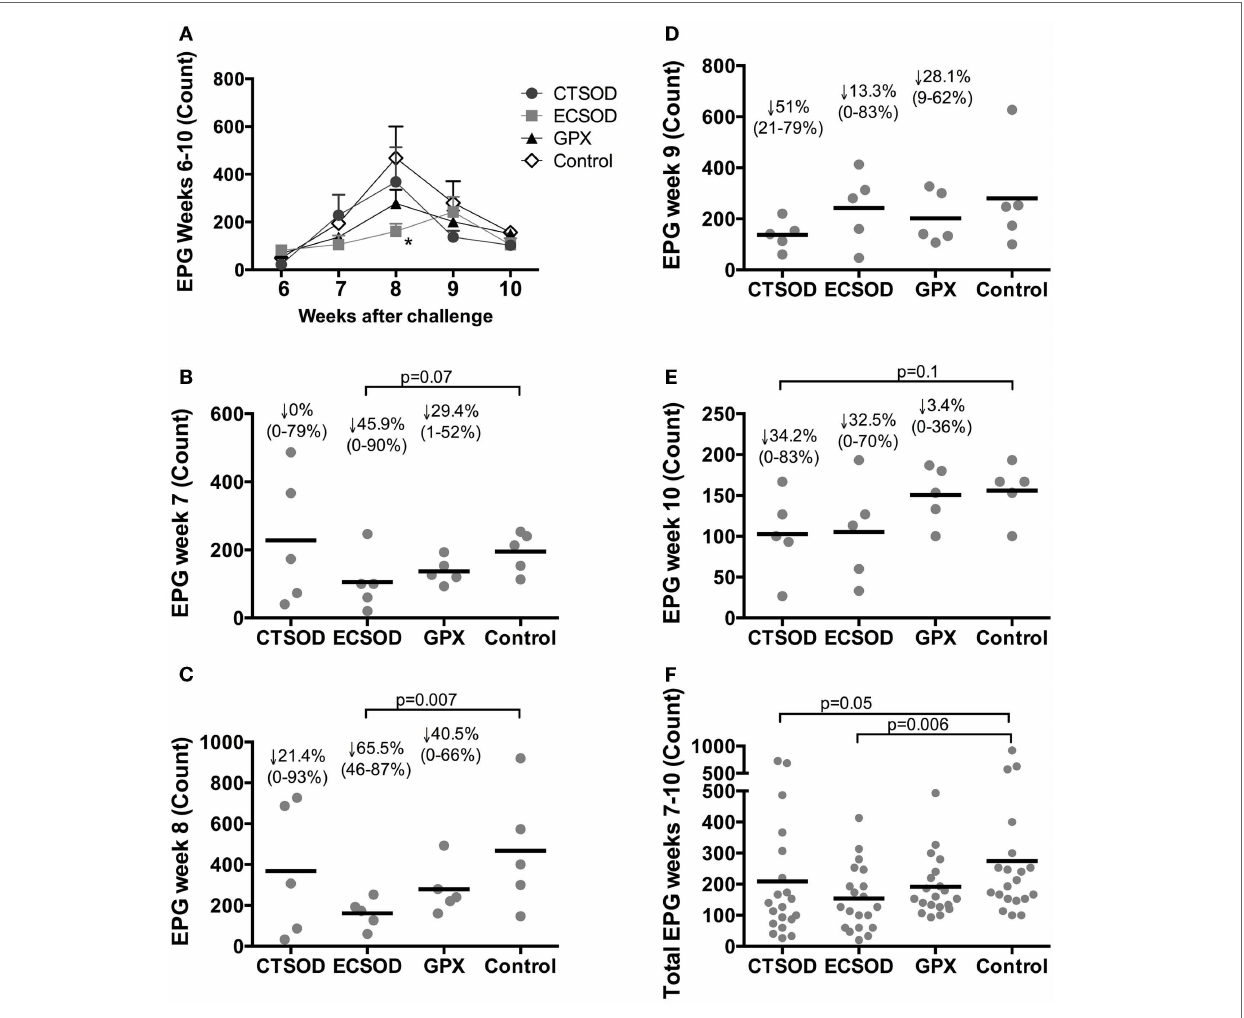
excreted over 5 weeks period (F) . The statistical p -value was expressed in comparison to the mean average of the Control group. Results were log-transformed and corrected for multiple analyses when applying ANOVA and student’s t -tests. Values were considered statistically significant when p <